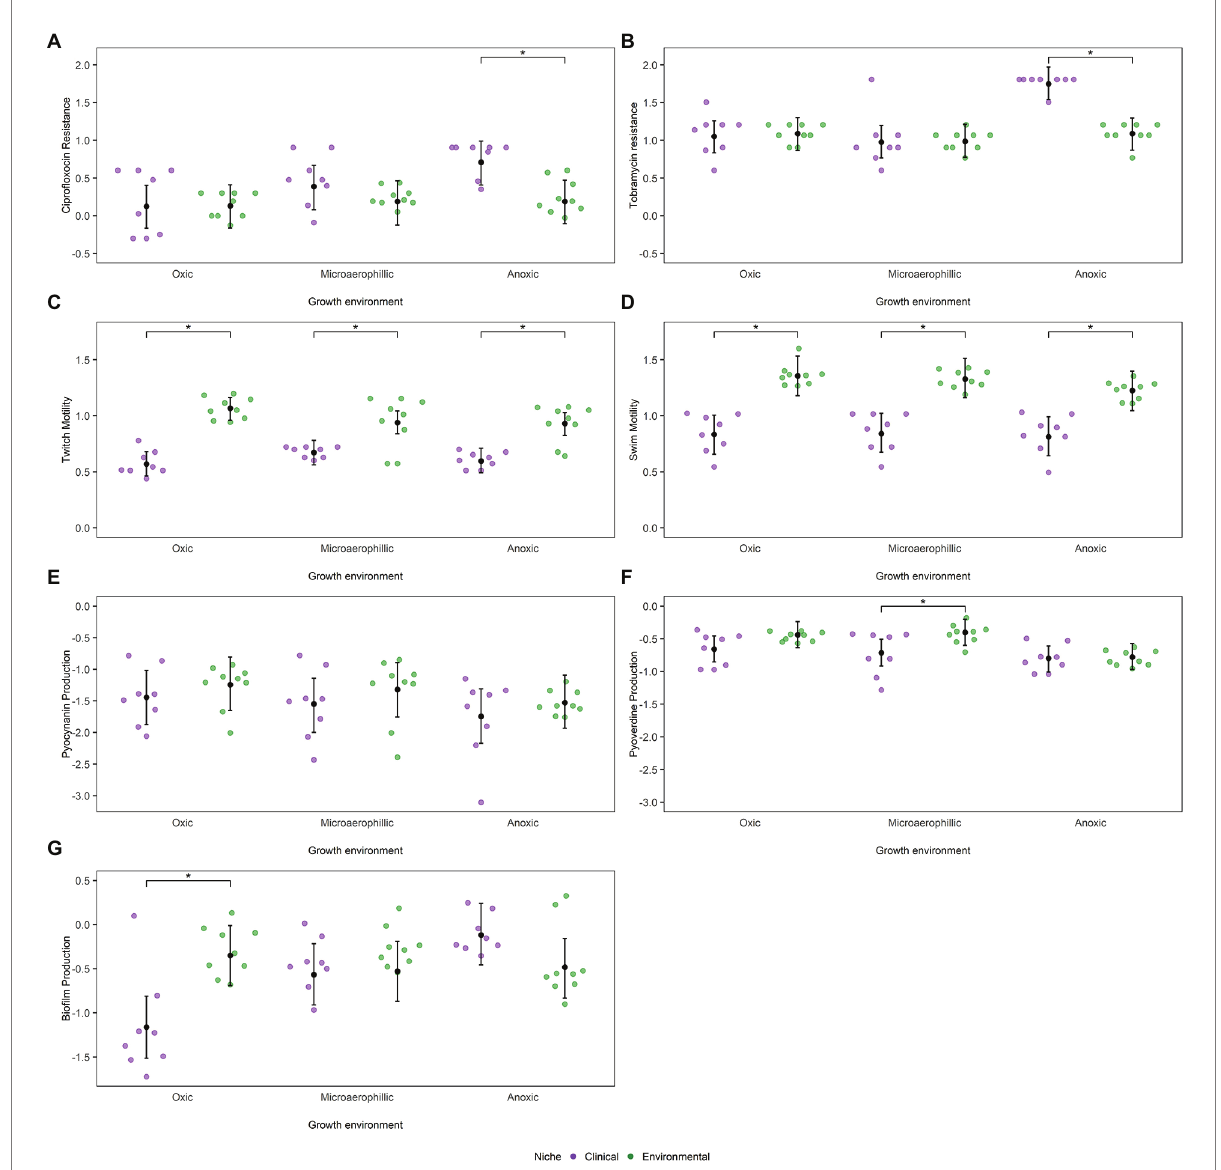
FIGURE 3 Dot plots represent mean values (log 10 transformed) of P. aeruginosa strains as a function of niche and environment for (A) ciprofloxacin MIC, (B) tobramycin MIC, (C) twitch motility, (D) swim motility, (E) pyocyanin production, (F) pyoverdine production and (G) biofilm formation. The posterior mean and 95% CIs are indicated by the black dot and whiskers, respectively, as calculated from the phylogenetic mixed model as determined by MCMCglmm. Statistically significant differences, α < 0.05, between niches as estimated by emmeans are depicted by